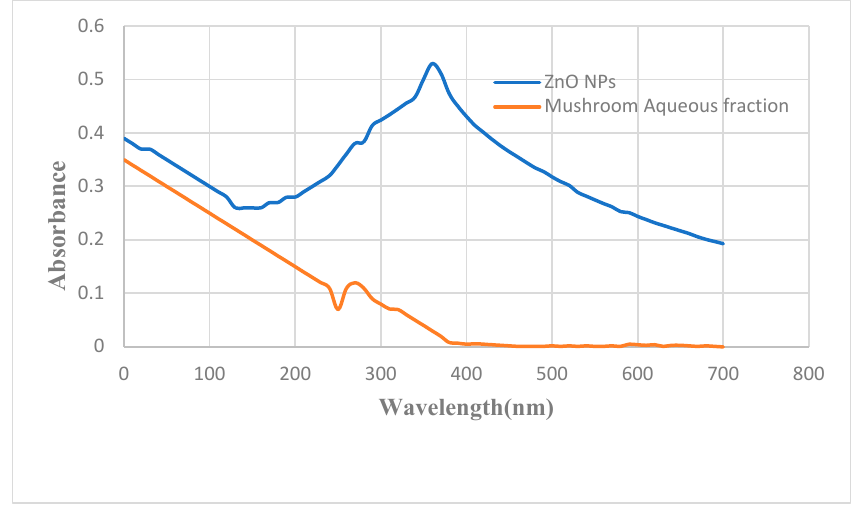
Figure 1. UV-Vis spectrum of ZnO NPs and L. edodes aqueous fraction.